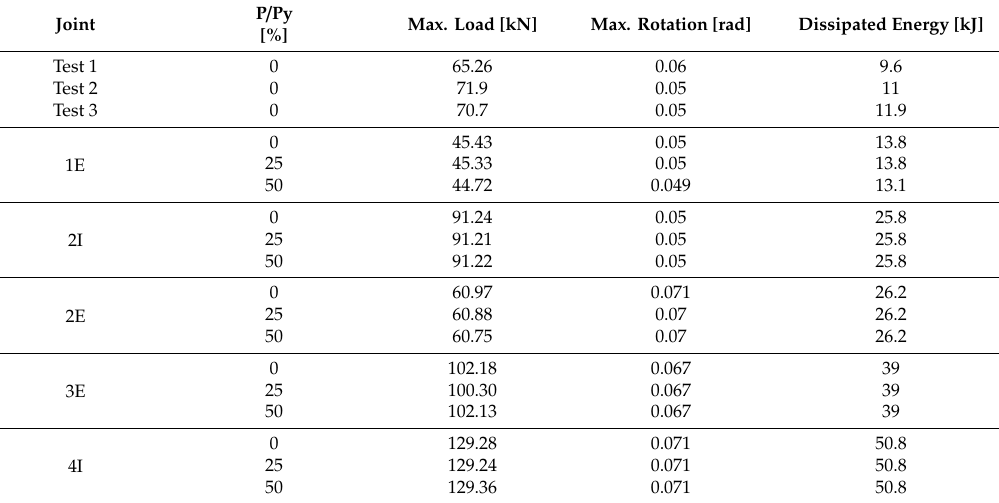
Table 4. Summary of equivalent load-displacement